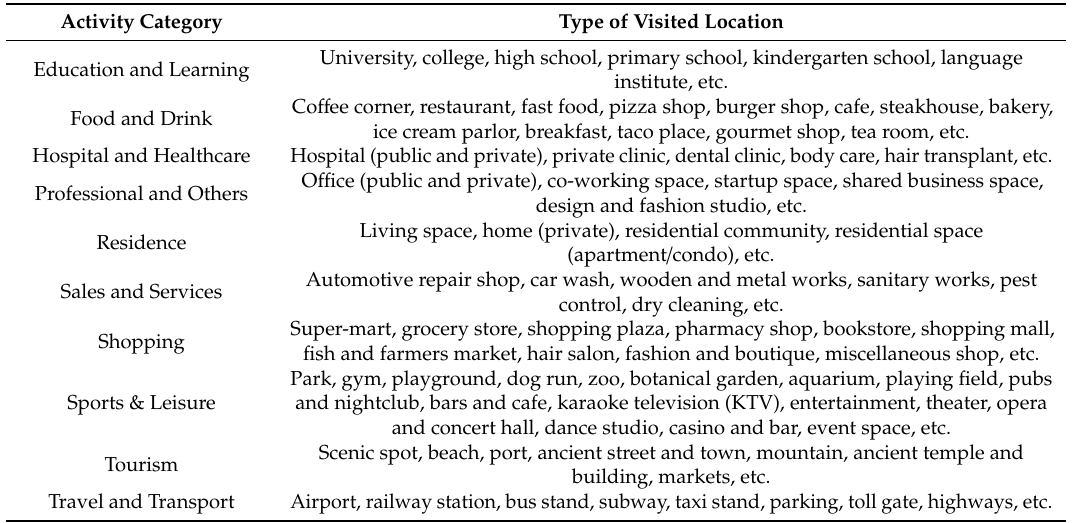
Table 2. Activities